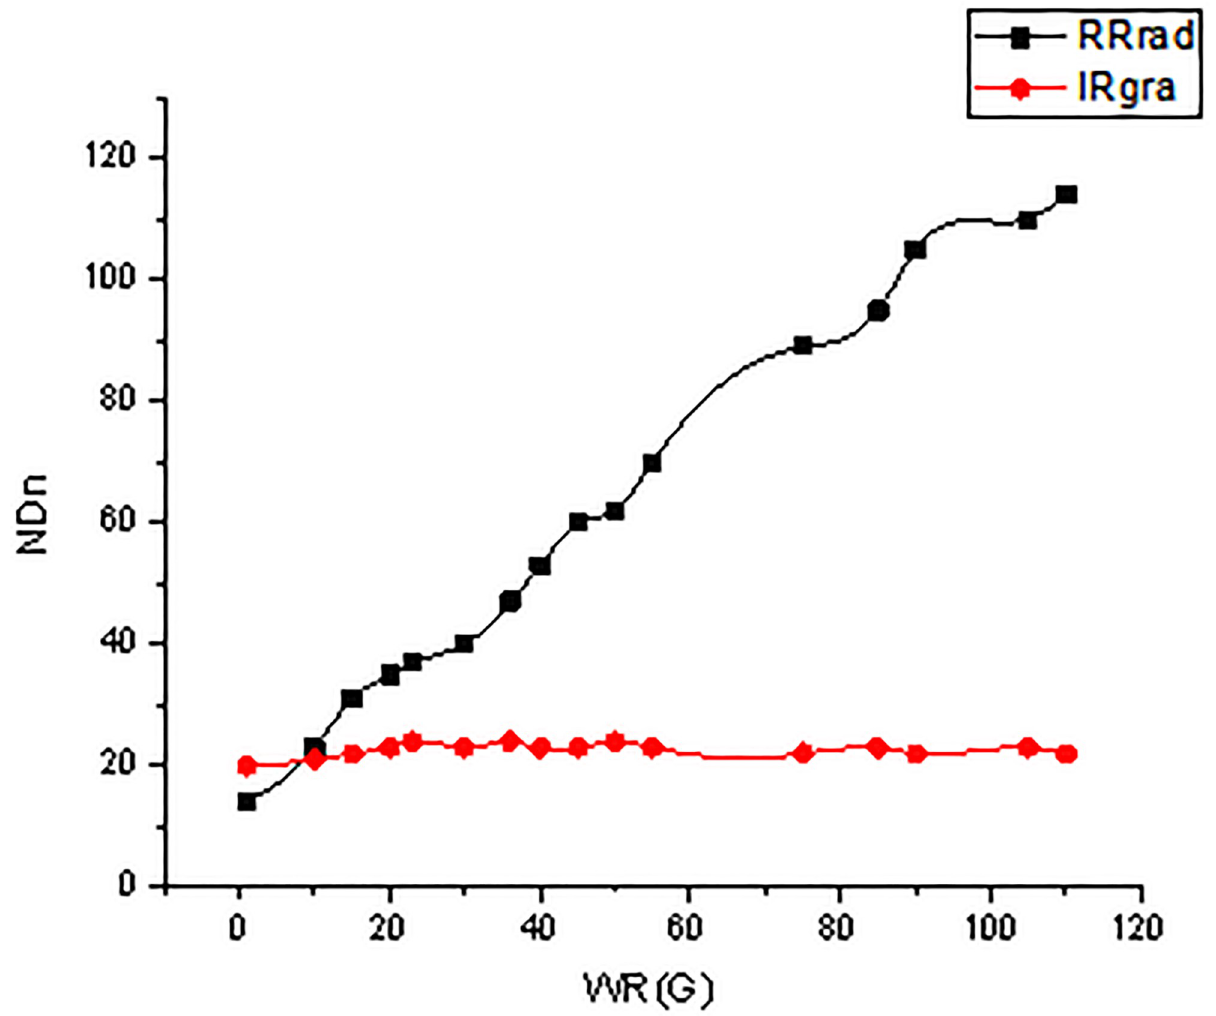
Fig 6. The change trend of new dynamic energy of manufacturing enterprises in the second stage with the degree of